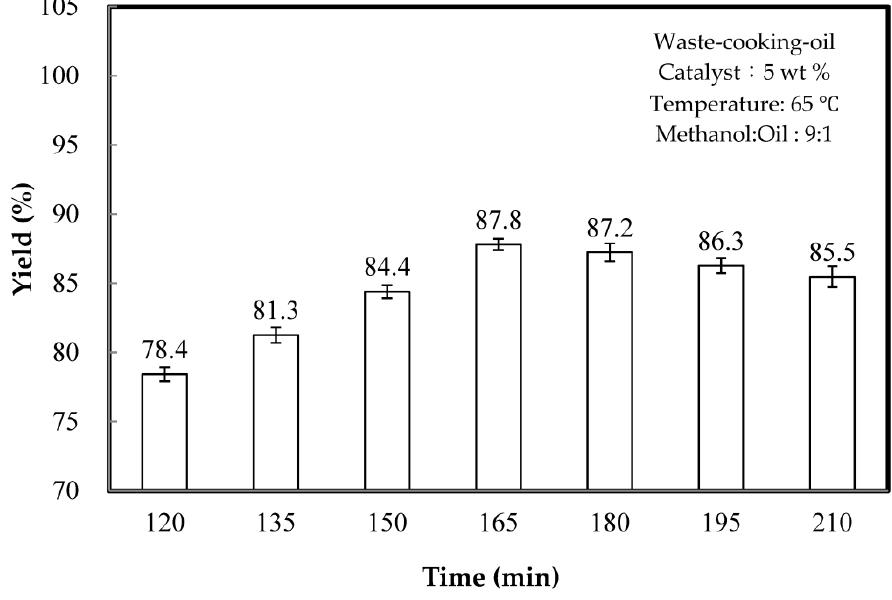
Figure 5. Effects of reaction time.